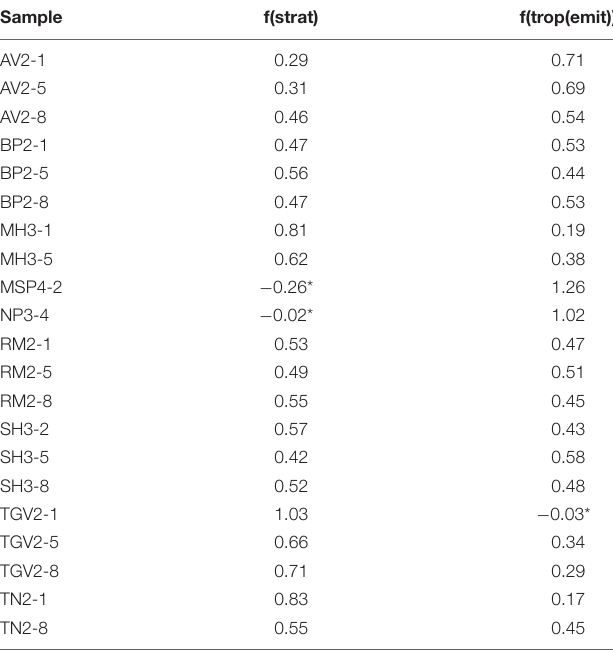
TABLE 4 | Two-component mixing model to determine relative contributions of different sources of NO 3 − . Sample